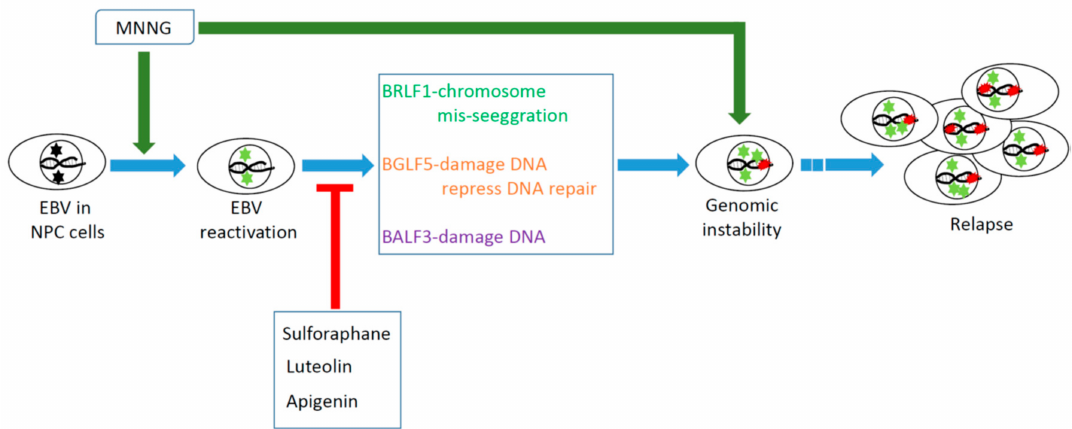
Figure 1. Epstein–Barr virus (EBV) reactivation induces genomic instability and subsequently causes the relapse of nasopharyngeal carcinoma (NPC). N -methyl- N (cid:48) -nitro- N -nitrosoguanidine